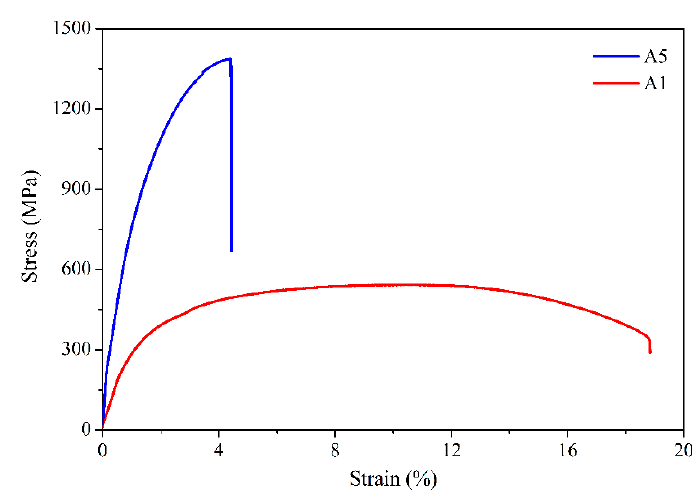
Figure 9. Stress–strain curves of the deposited 410L alloy and Fe–Cr–B–Si–Mo alloy specimens.